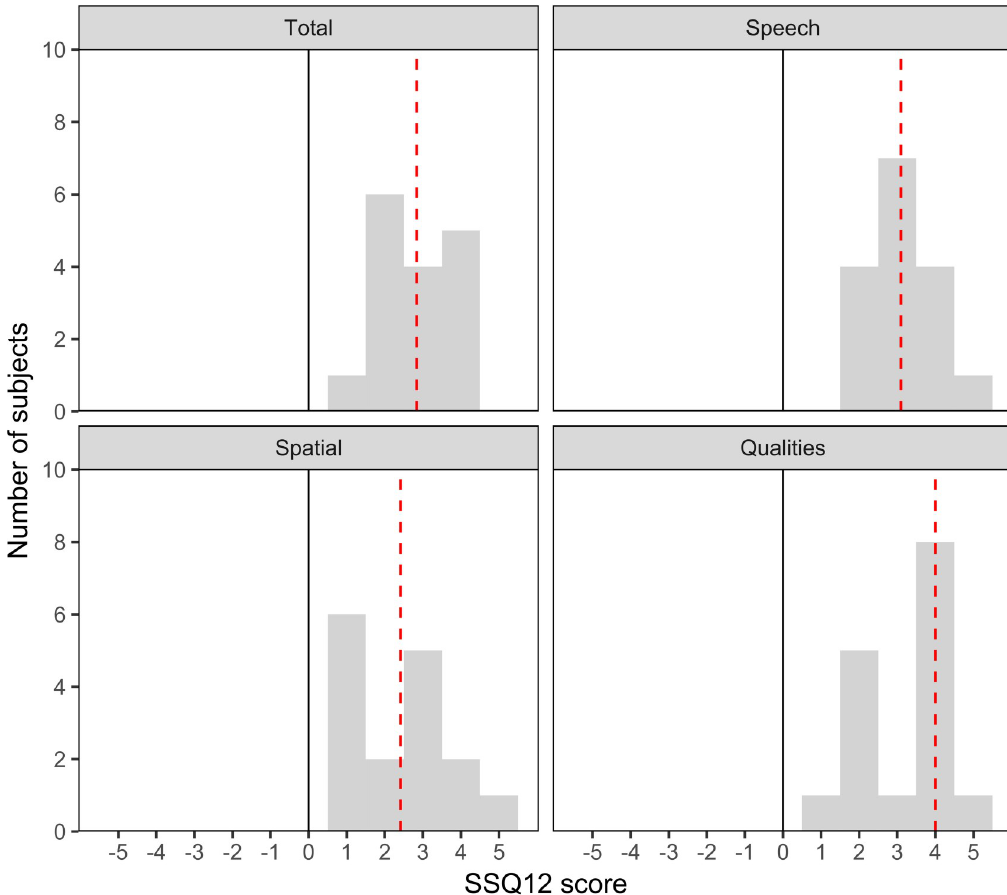
Fig 1. SSQ12-B. The SSQ12-B diagram shows the frequency of subjective scores ranging from -5 to +5 in every subcategory (“spatial”, “speech”, “qualities”) and in the overall score (“total”). The mean is given as dotted